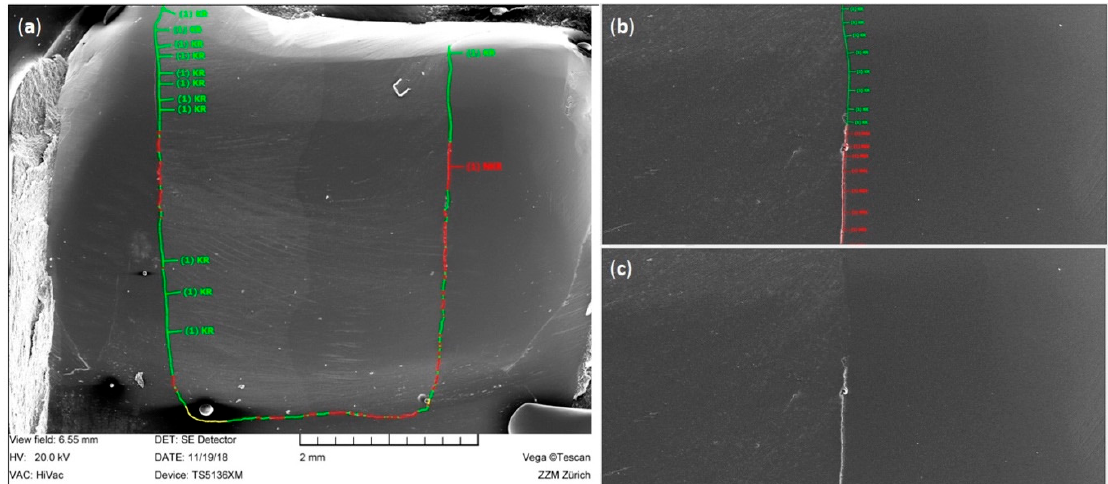
Figure 4. Illustration of the quantitative SEM margin analysis performed in this study. ( a ) SEM image of the entire proximal margin with classified continuous (green), non-continuous (red), and not judgeable (yellow) margin segments; ( b ) detail of image ( a ) with classified margin segments at 200 × magnification; ( c ) same image as ( b ) without labeled margin segments.